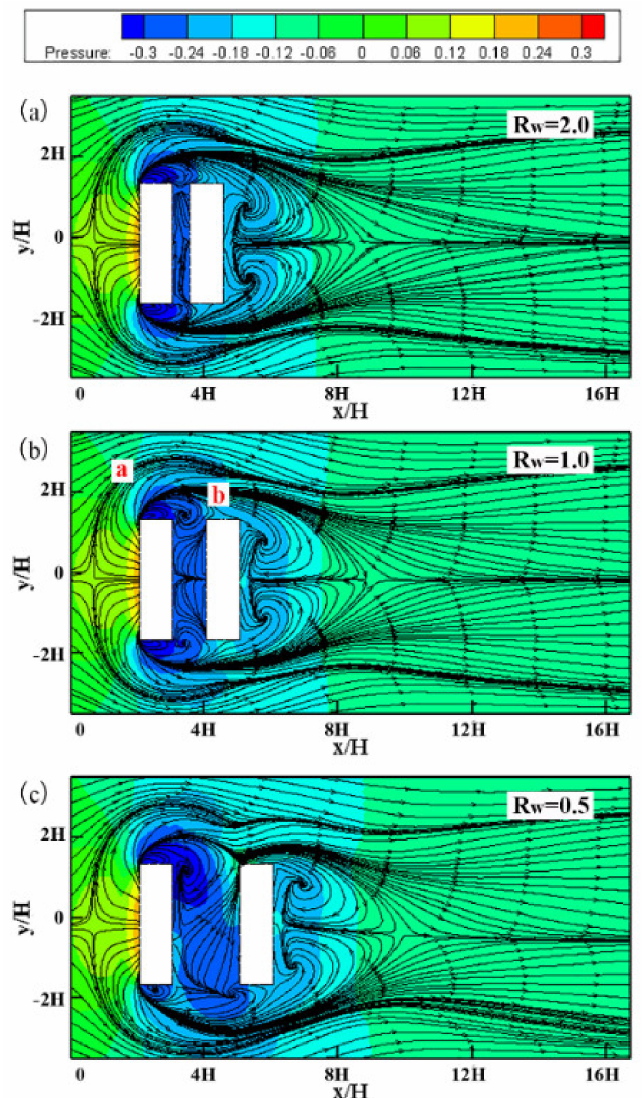
Figure 5. Time-averaged streamlines and pressure contours on the horizontal plane (z/H = 0.01) of streets with different aspect ratios: ( a ) R w = 2.0; ( b ) R w = 1.0; ( c ) R w =